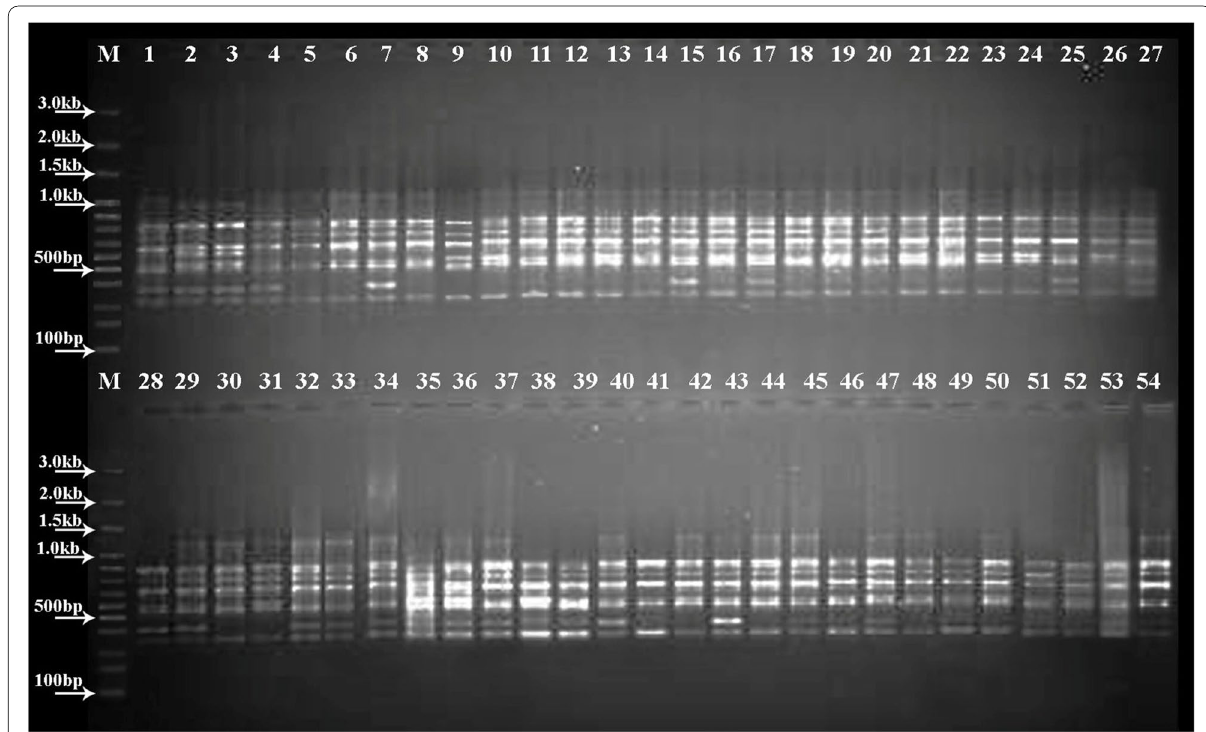
Fig. 1 Amplification profile of UBC 807 primer among 54 Capsicum accessions. In the figure, M represents the DNA ladder and Lanes 1–27 and 28–54 represent different Capsicum accessions which are displayed in Table 1